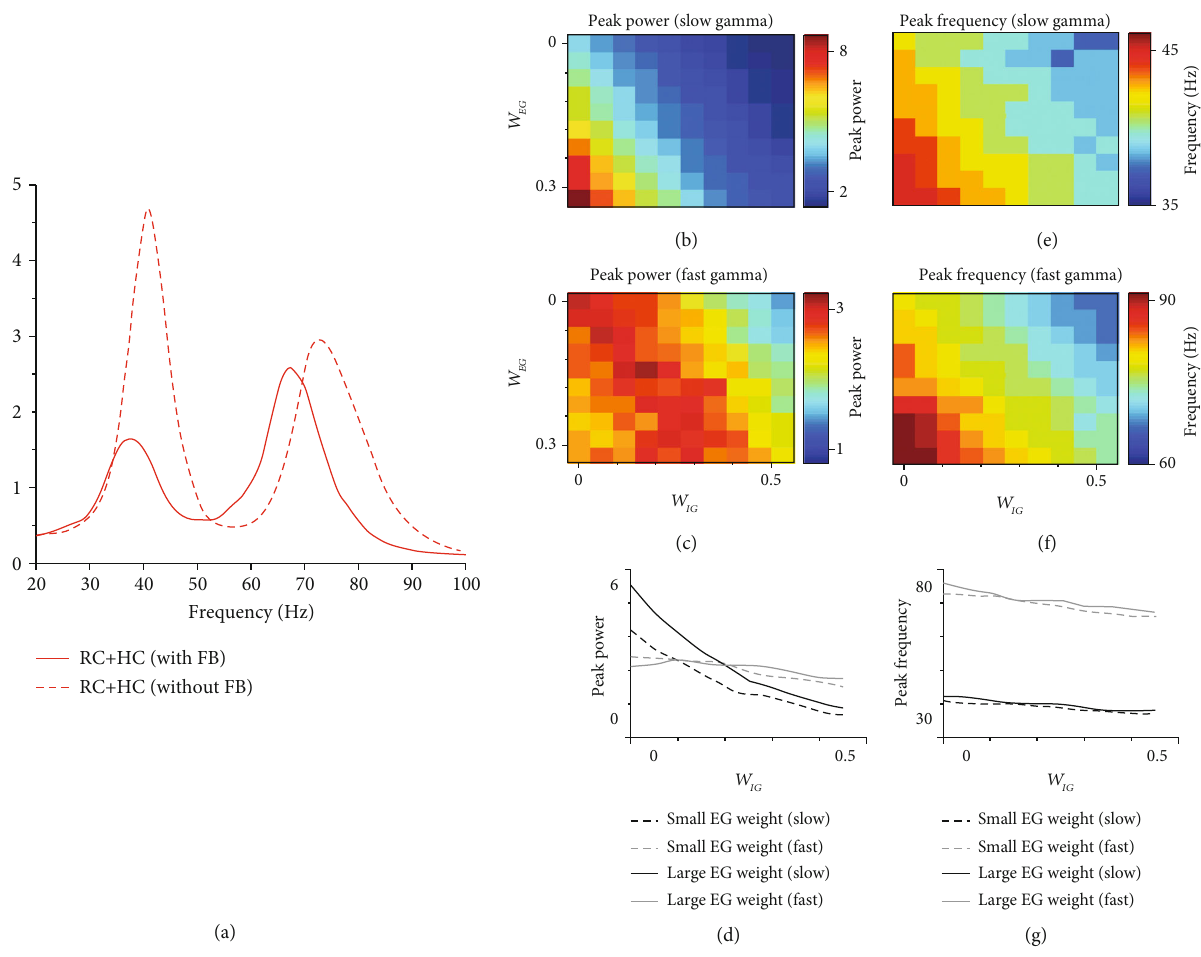
Figure 4: Modulation of gamma oscillations in HC network with FB. (a) shows the power spectrum of the LFPs from two example networks (solid red curve is the power spectrum from the network with FB, and the dashed red curve is from the network without FB). (b – g) are similar to Figures 3(c) – 3(h). The powers of slow and fast gamma for di ff erent FB connection strength are shown in (b) and (c), respectively. (d) shows how peak power changes with connection weight W IG at two W EG values (similar to color plots (b) and (c)). The black line denotes the case of slow gamma (dashed black line for W EG = 0 , and solid black line for W EG = 0 : 09 ), and grey line is for that of fast gamma (dashed grey line for = 0 , and solid grey line for W = 0 : 09 ). The peak frequency of slow and fast gamma for di ff erent connection strength is shown in (e) and (f), respectively. (g) shows how peak frequency changes of connection weight W IG corresponding to the color plot in (c) and (d). The black line denotes the case of slow gamma (dashed black line for W EG = 0 , and solid black line for W EG = 0 : 09 ), and grey line is for that of fast gamma (dashed grey line for W EG = 0 , and solid grey line for W EG = 0 : 09